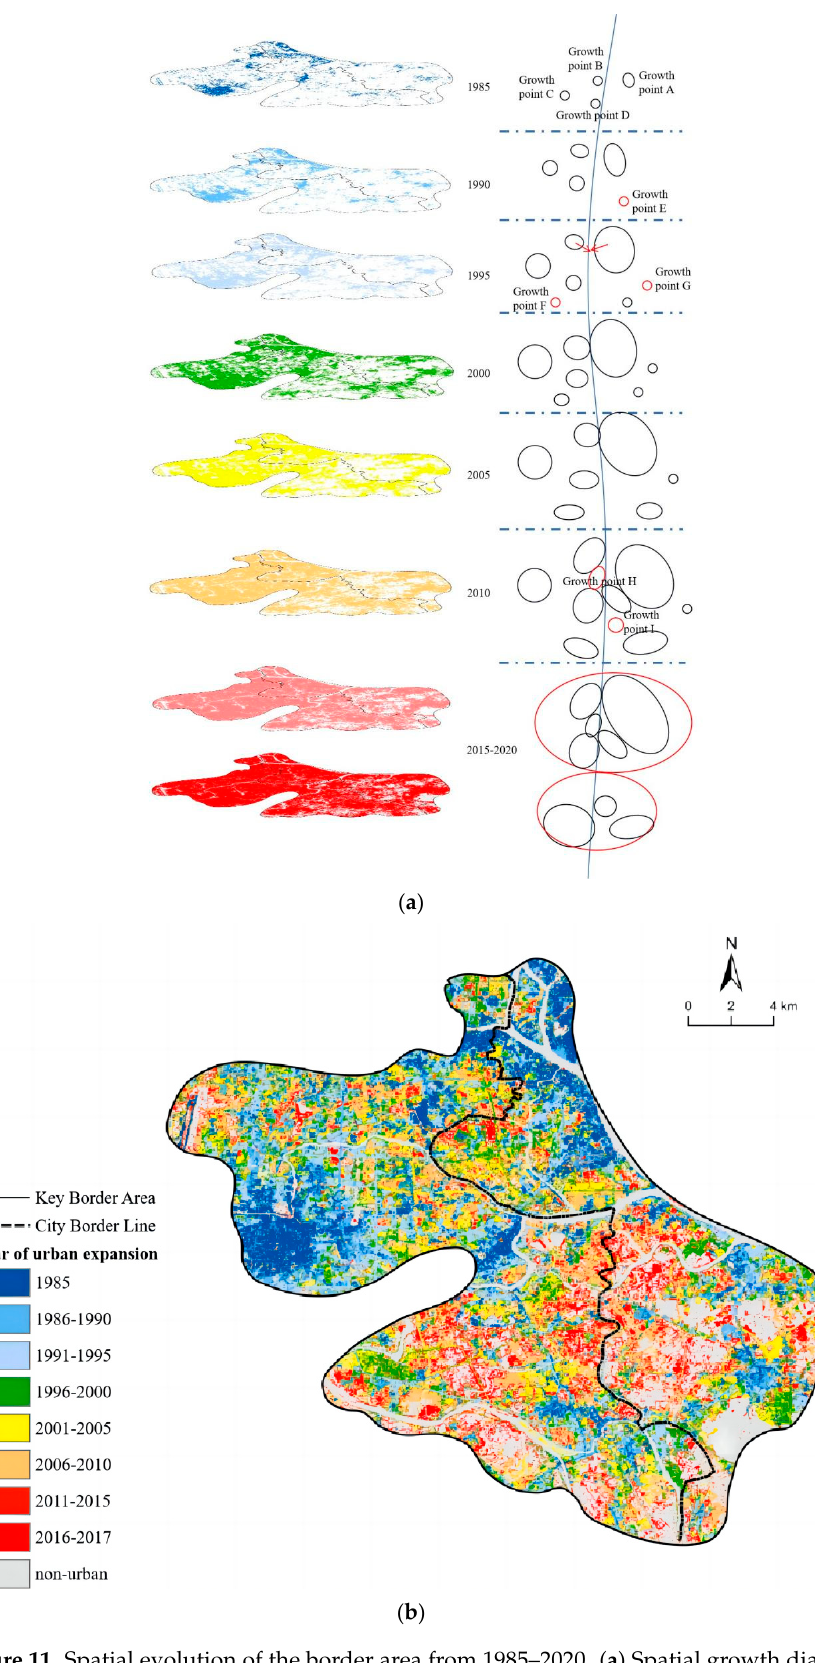
Figure 11. Spatial evolution of the border area from 1985–2020. ( a ) Spatial growth diagram of key border areas of Guangzhou-Foshan from 1985–2020; ( b ) Evolutionary pattern of spatial expansion of key border areas of Guangzhou-Foshan, 1985–2020.